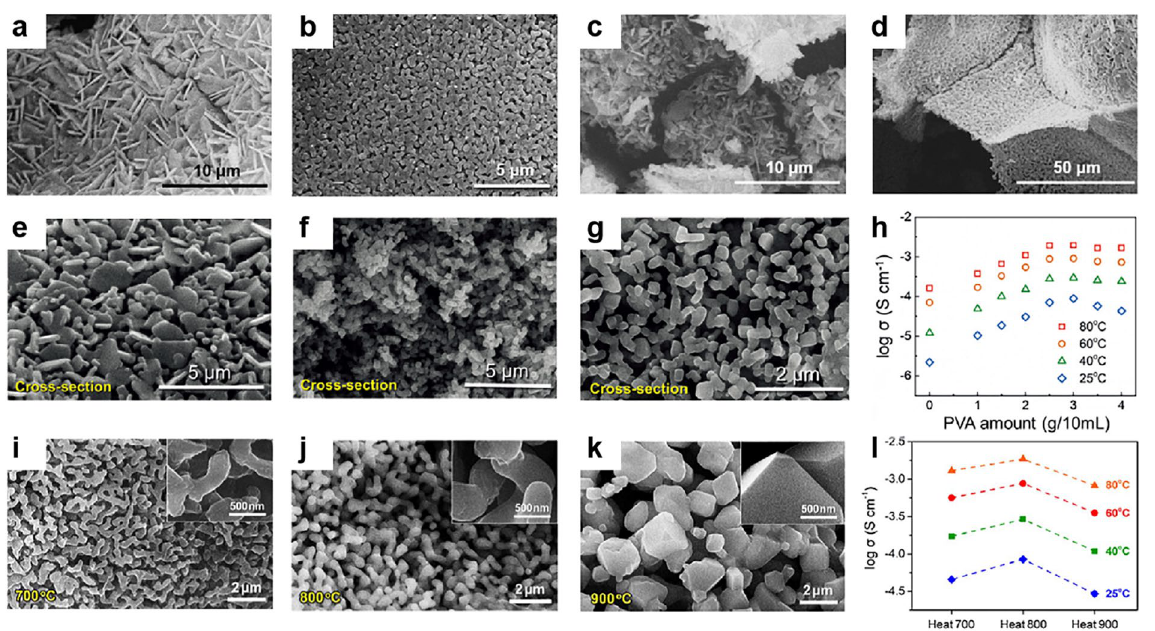
Fig. 7 SEM images of the LLTO framework with different LLTO amounts of a, b 1 mmol and c, d 3 mmol. The surface morphologies of LLTO frameworks after heat treatment at 800 °C with different amounts of PVA: e 0.75 g, f 1.5 g, and g 3.0 g. h The conductivity of LLTO CSEs with different PVA amounts from 0 (pure PEO) to 4 g. a – h Reproduced with permission [152]. Copyright 2018, Wiley–VCH. SEM images of 3D garnet frameworks heat treated at i 700 °C, j 800 °C, and k 900 °C for 2 h. The insets show high-magnification SEM images of 3D garnet frameworks. l Conductivity of 3D-CSEs with garnet frameworks heat treated at 700 °C (heat 700), 800 °C (heat 800) and 900 °C (heat 900). i – l Reproduced with permission [153]. Copyright 2018,